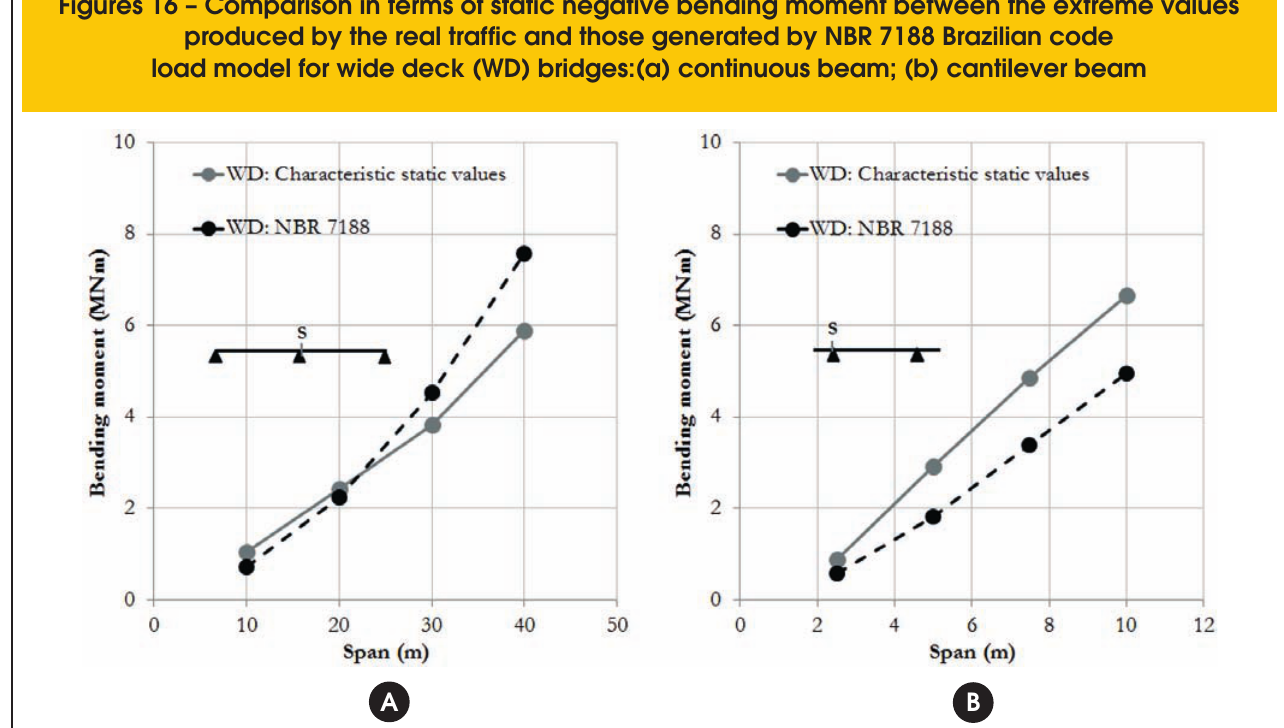
Figures 16 – Comparison in terms of static negative bending moment between the extreme values produced by the real traffic and those generated by NBR 7188 Brazilian code load model for wide deck (WD) bridges:(a) continuous beam; (b) cantilever